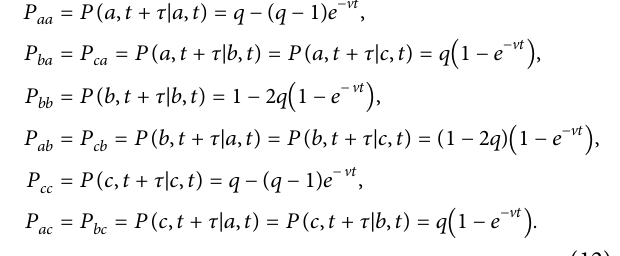
Figure 1: (a) Potential U values of α